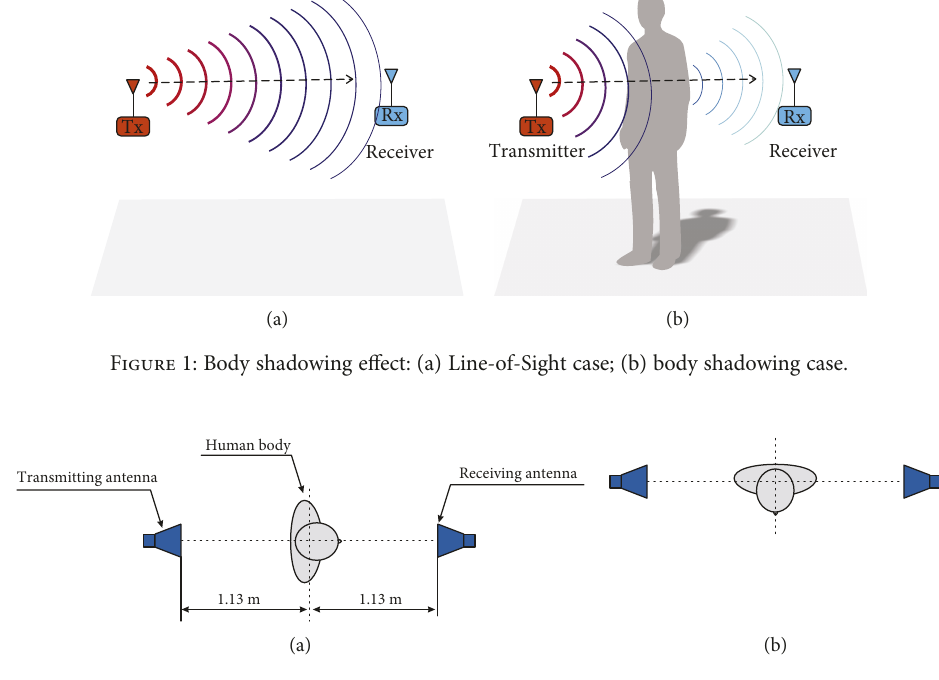
Figure 2: Geometry of the measurement experiment: (a) body orientation 1 and (b) body orientation